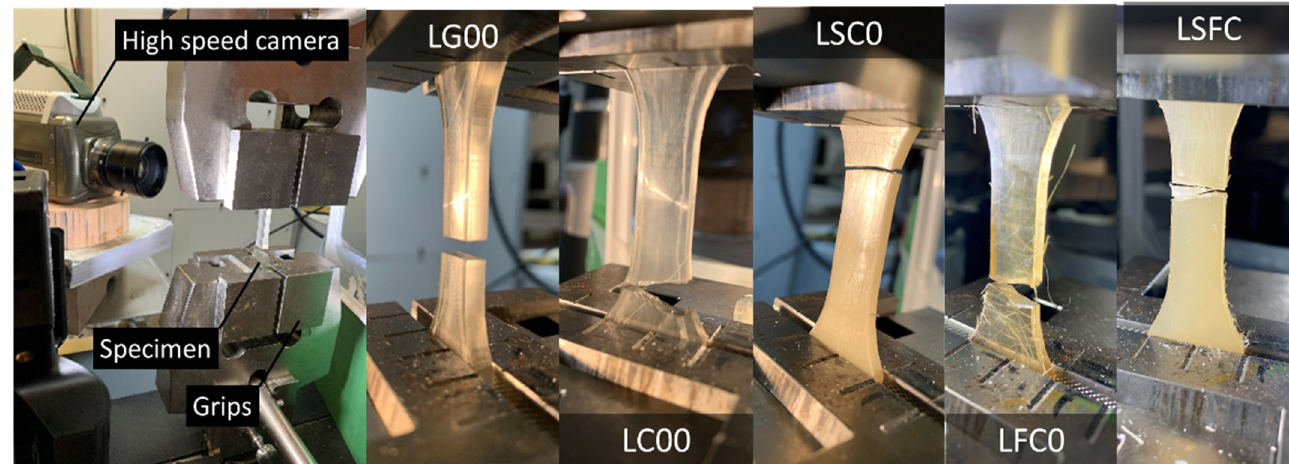
Figure 2. Tensile testing experiments showing the setup with high-speed camera monitoring and ruptured specimens for selected composites.